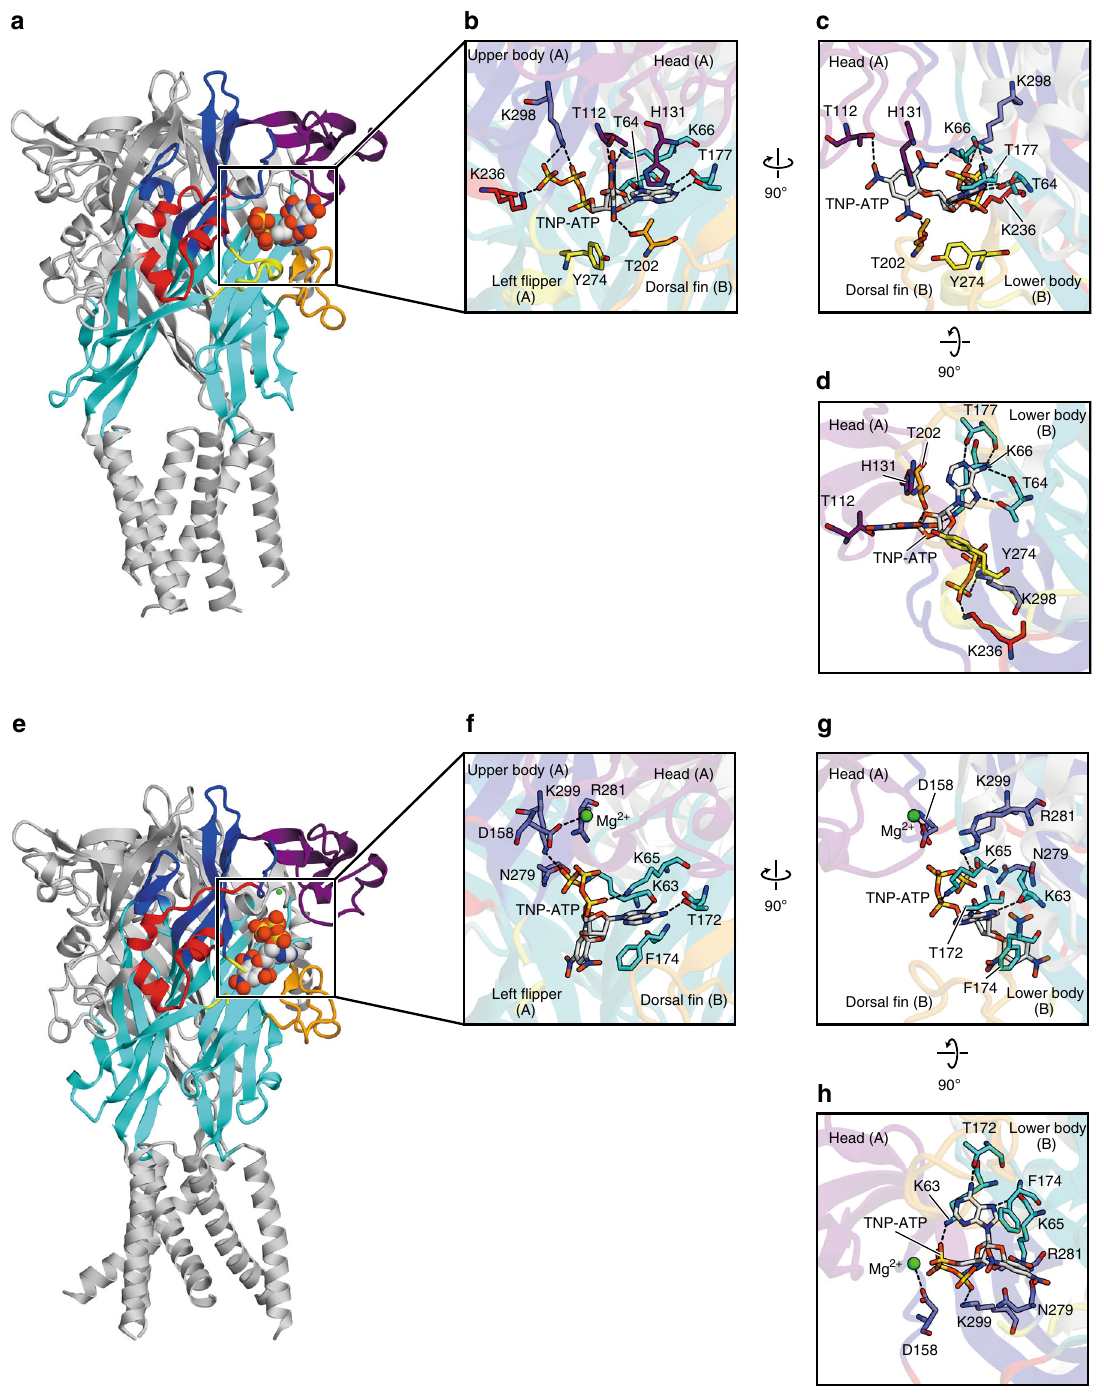
Fig. 3 Comparison of TNP-ATP binding sites in the TNP-ATP-bound structures of ckP2X7 and hP2X3. a – d Overall ( a ) and close-up ( b – d ) views of the TNP- ATP binding sites in the TNP-ATP-bound ckP2X7 structure. e – h Overall ( e ) and close-up ( f – h ) views of the TNP-ATP binding sites in the TNP-ATP-bound hP2X3 structure (PDB ID: 5SVQ) ( b ). The molecules are colored according to the dolphin-like model 20 . The TNP-ATP and amino-acid residues are depicted by stick models. The Mg 2+ ion is depicted by a green sphere . Dotted black lines indicate hydrogen bonds ( < 3.3